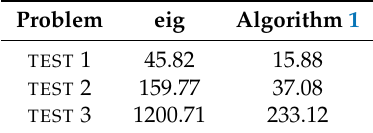
Table 4. Comparison of Algorithm 1 and eig for CPU time in